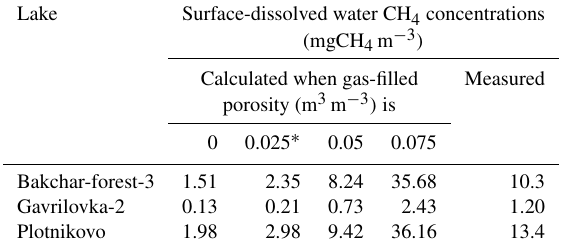
Table 2. Surface-dissolved water CH 4 concentration (mgCH 4 m − 3 ) in three ST lakes, both measured and calculated assuming a range of values of gas-filled porosity. Lake Surface-dissolved water CH 4